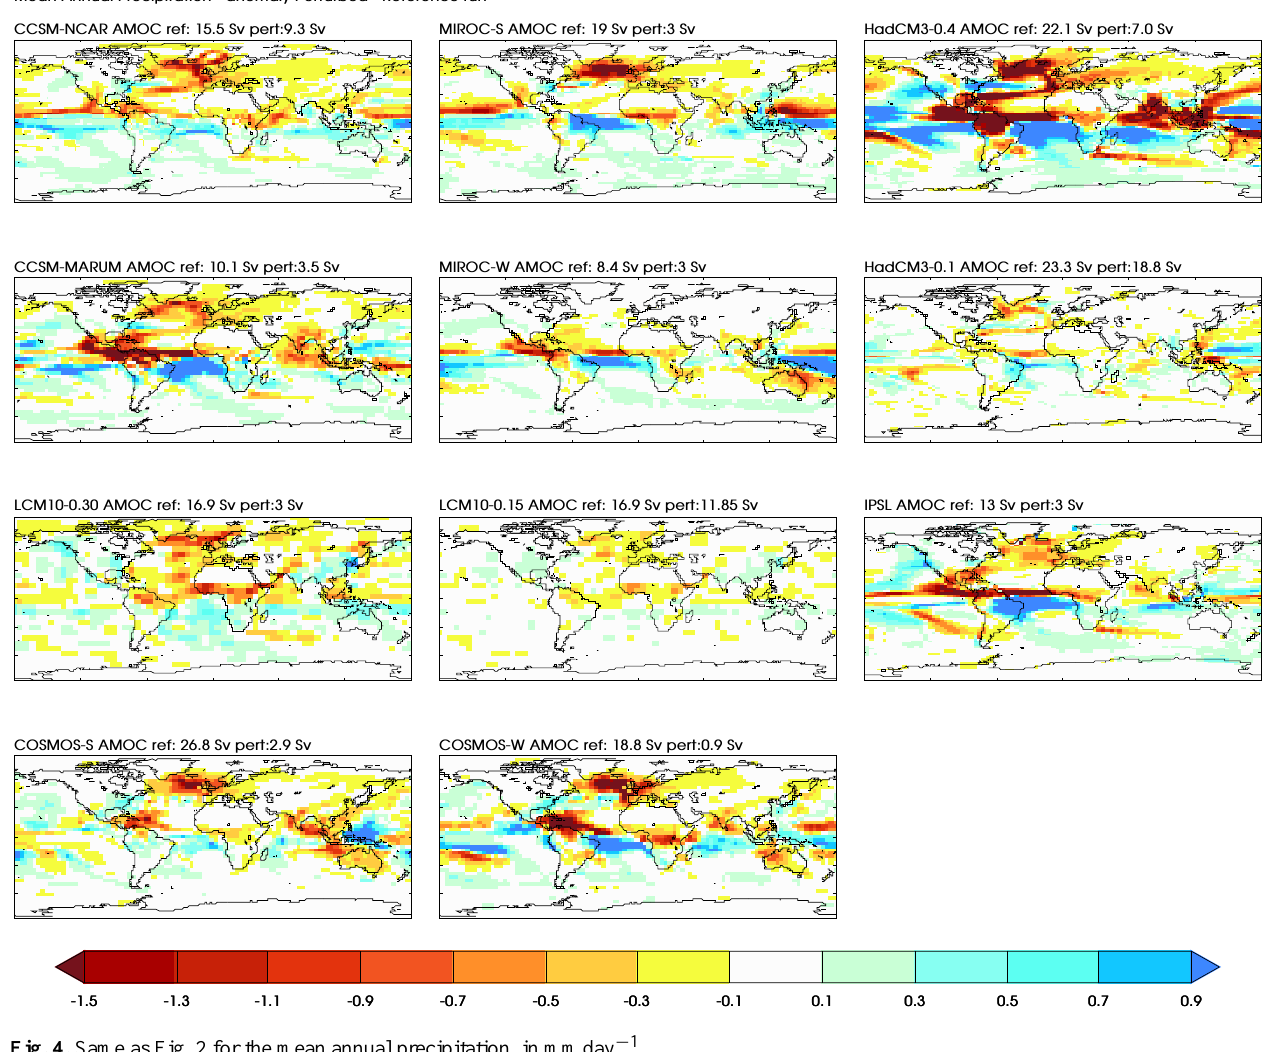
Fig. 4. Same as Fig. 2 for the mean annual precipitation, in mmday − 1